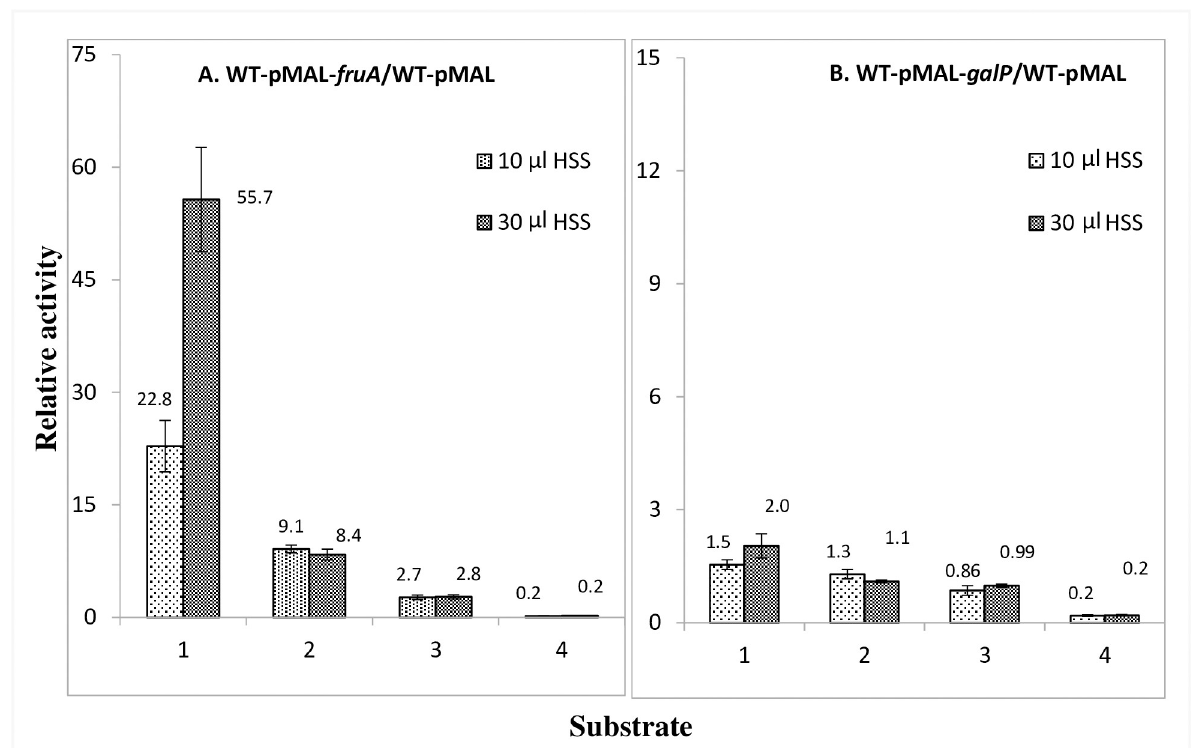
Fig 6. Effects of using a HSS from lysed E . coli BW25113 chs kn : T : Ptet-fruBKA cells, overexpressing the fruBKA operon, on the PEP-dependent phosphorylation activities of enzymes II in membrane pellets (MP) of E . coli BW25113 overexpressing fruA (A) or galP (B) for PTS sugars: 1, Fructose; 2, Mannitol; 3, N-acetylglucosamine and 4, Galactitol. An aliquot of an 8 h HSS from E . coli BW25113 chs kn : T : Ptet-fruBKA (WT OE fruBKA operon) was used as a source of soluble PTS enzymes for the measurement of PEP-dependent phosphorylation activities. The raw data are presented in S24 Table.